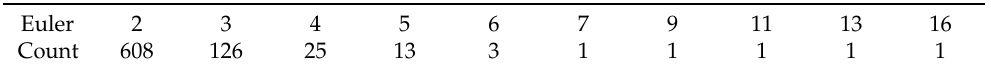
Table 9. Third decomposition type—distribution of combinatorial Euler characteristics of Trian- gle3DNet objects from border interior overlay.